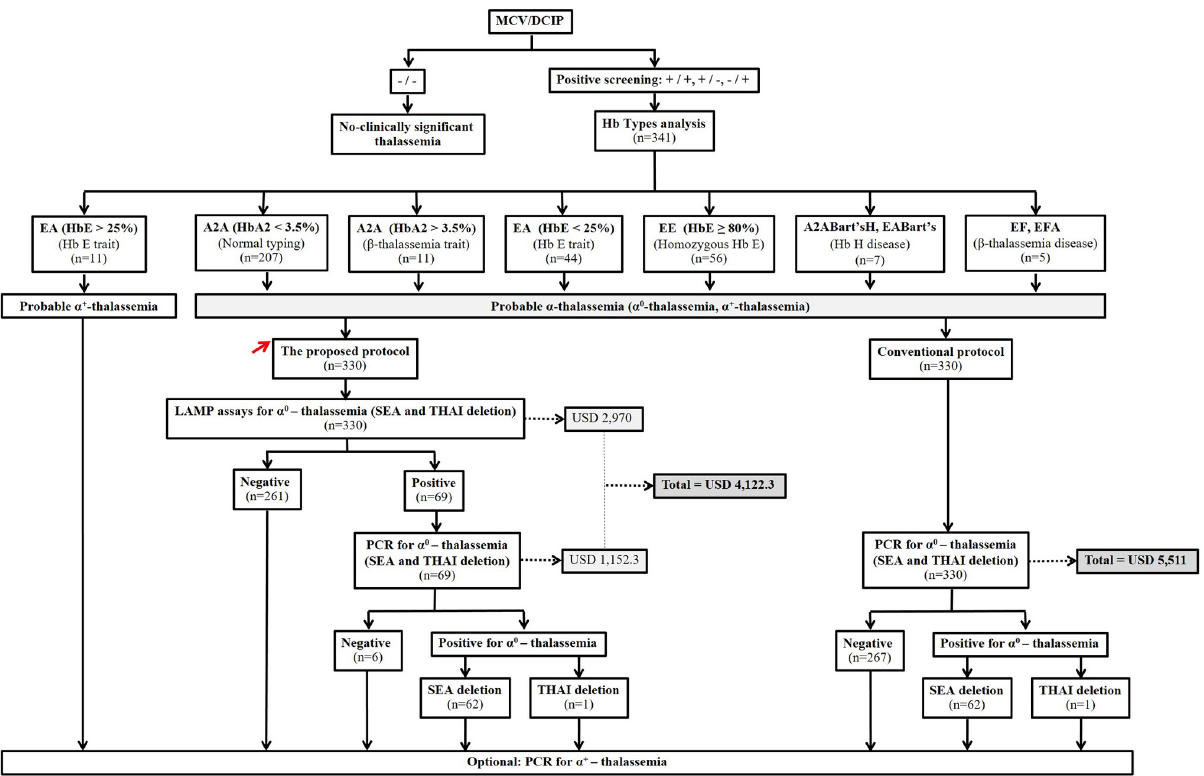
Fig 3. Comparison of the conventional screening protocol without LAMP colorimetric assay and the proposed screening protocol with LAMP colorimetric assay for α 0 -thalassemia. The cost-effectiveness of the two protocols was also determined on the 341 subjects. The PCR analysis of α 0 - thalassemia is needed for 330 subjects with the conventional screening protocol, whereas only 69 subjects are required for PCR analysis of α 0 - thalassemia with the proposed protocol. Break down of the 341 subjects in each screening protocol is indicated. DCIP, dichlorophenolindophenol; OF, osmotic fragility; MCV, mean corpuscular